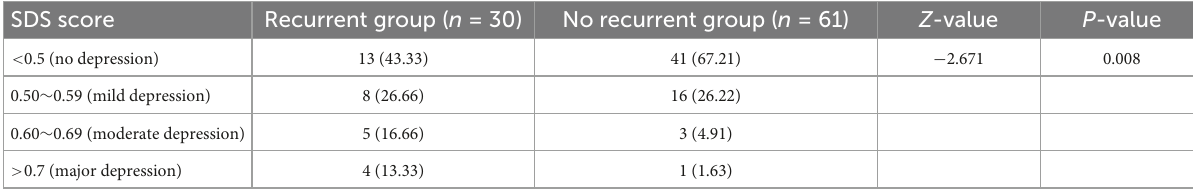
TABLE 2 Comparison of SDS score between two groups ( n %).